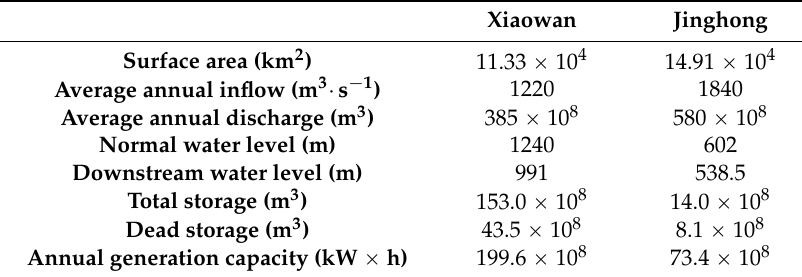
Table 1. Details about Xiaowan Dam and Jinghong Dam